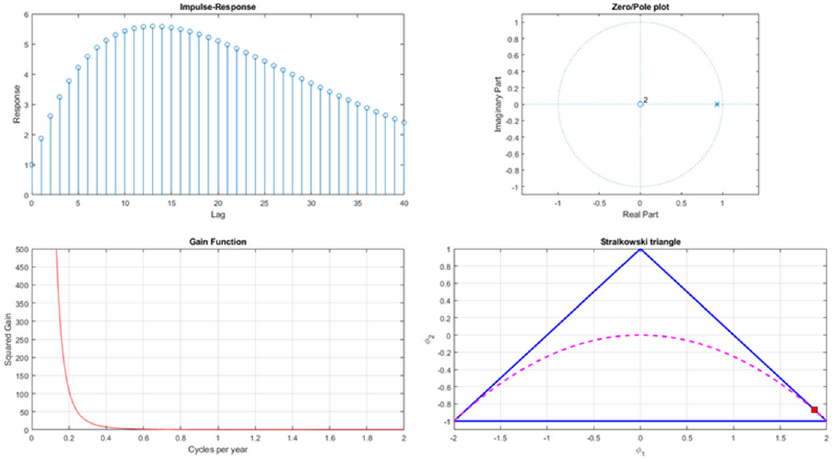
Fig. 8 Features of the AR(2) estimates. Constrained